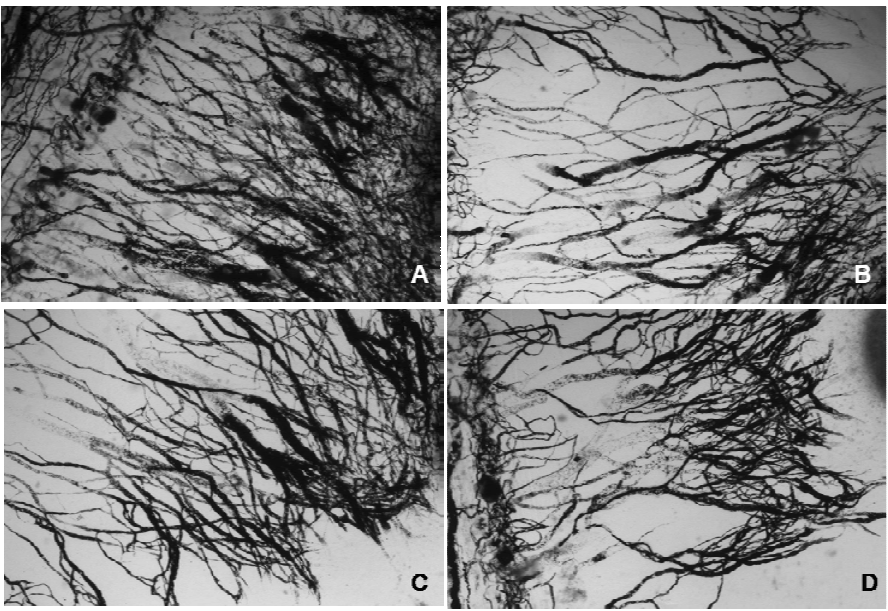
Fig. 2 – Images of the corneal newly formed vessels on day 7 after silver nitrate